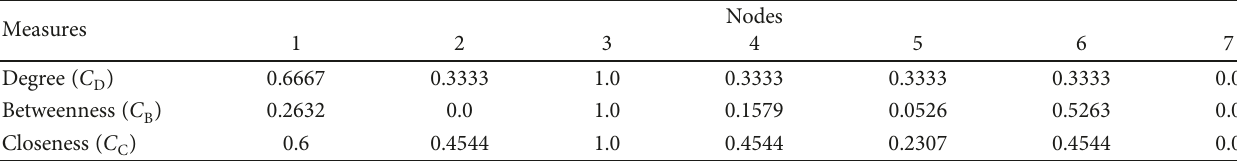
Table 2: The normalized data of three measures for the running